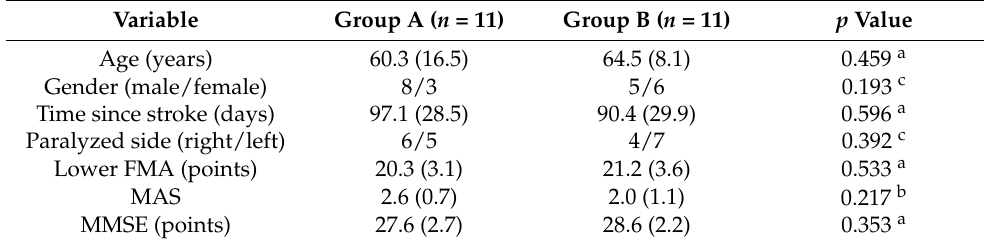
Table 2. Characteristics of the two